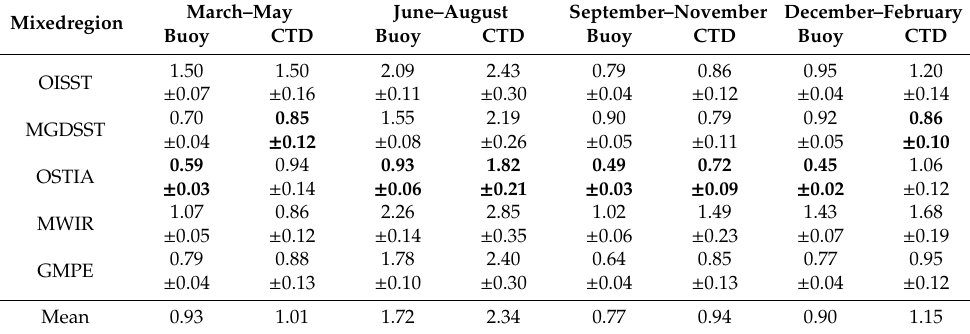
Table 4. Seasonal variations in the RMSD between the L4 gridded SST products (mostly based on satellite observation) and the in situ measurements (ocean buoys and research vessels) in the shallow and vertically well-mixed region. The lowest RMSD in each column is given in bold